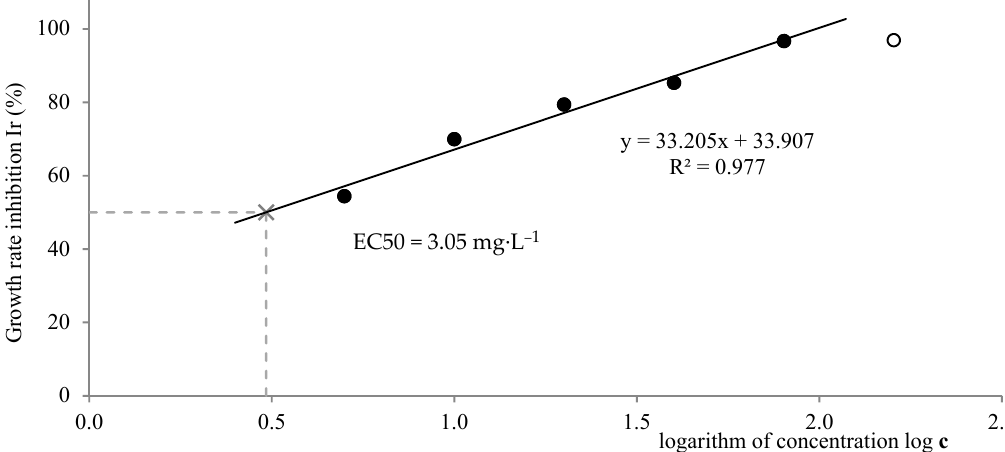
Figure 10. Graphical results of the test on the Lemna minor from area measurement (image analyzing).